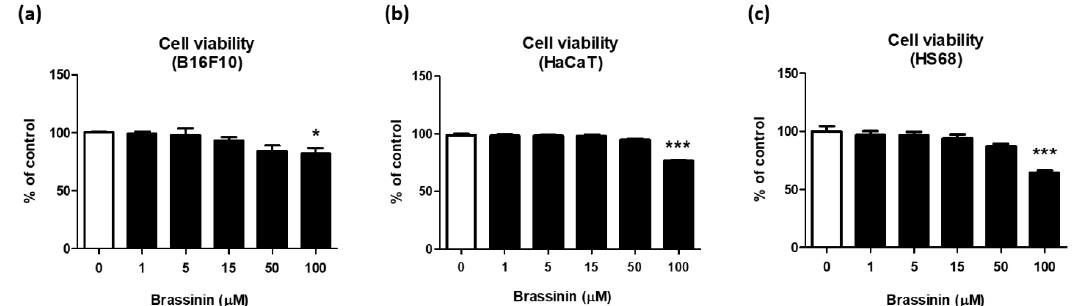
Figure 2. Effects of brassinin on cell viability in B16F10, HaCaT, and HS68 cells. Cell viability was measured in ( a ) B16F10, ( b ) HaCaT, and ( c ) HS68 cells treated with various concentrations of brassinin (1 – 100 μM) for 24 h ( n = 4/group). Results are presented as a mean ± SEM. * p < 0.05, *** p < 0.001 compared with the non-treated control group.